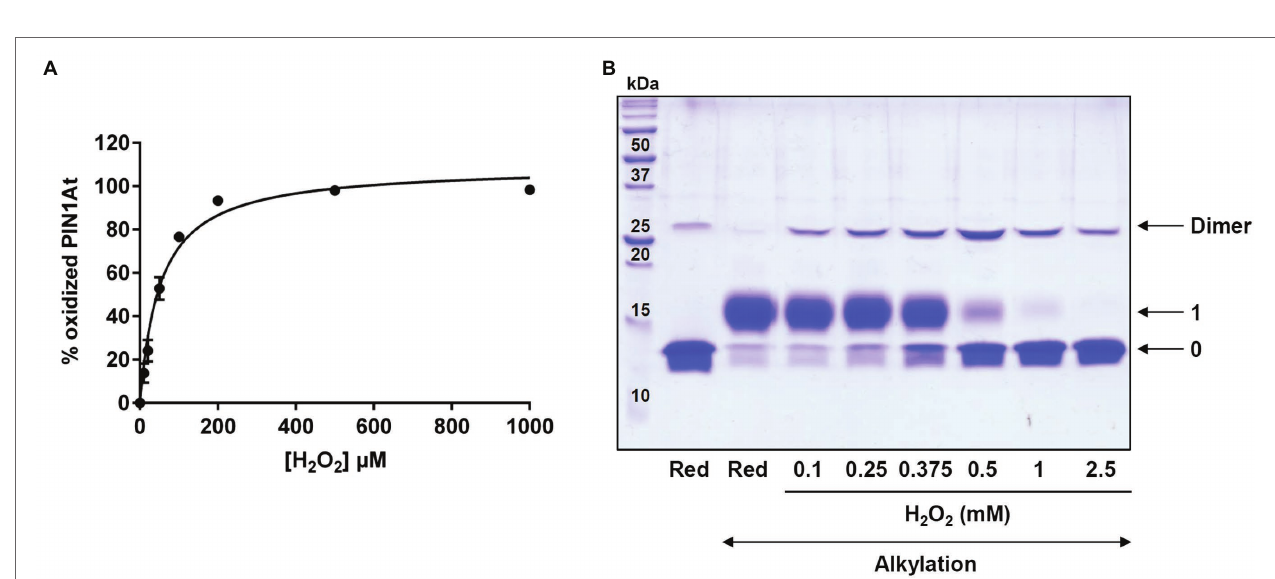
FIGURE 3 | H 2 O 2 -dependent inactivation of PPIase activity of PIN1At. (A) The PPIase activity of reduced PIN1At treated or not with 25- or 100-fold excess H 2 O 2 was measured using chymotrypsin-coupled assay in the presence of 200 μ M of suc-AEPF-p-NA as substrate. The activity of the untreated PIN1At was set to 100%. The data represent the mean ± SD and t -test p value (** p < 0.05) of six independent experiments. (B) Reduced PIN1At protein (20 μ M) was treated or not or not with 25- or 100-fold excess H 2 O 2 for 30 min. Protein sample treated with 100-fold excess H 2 O 2 was incubated with 10 mM DTT(red) for 30 min after protein precipitation and alkylation of free thiol groups with 2 kDa mPEG-maleimide (except in one reference line), protein mixtures were separated on non-reducing SDS-PAGE 15%. The numbers on the right correspond to the number of thiols that remained reduced upon treatment and thus were alkylated with mPEG maleimide.